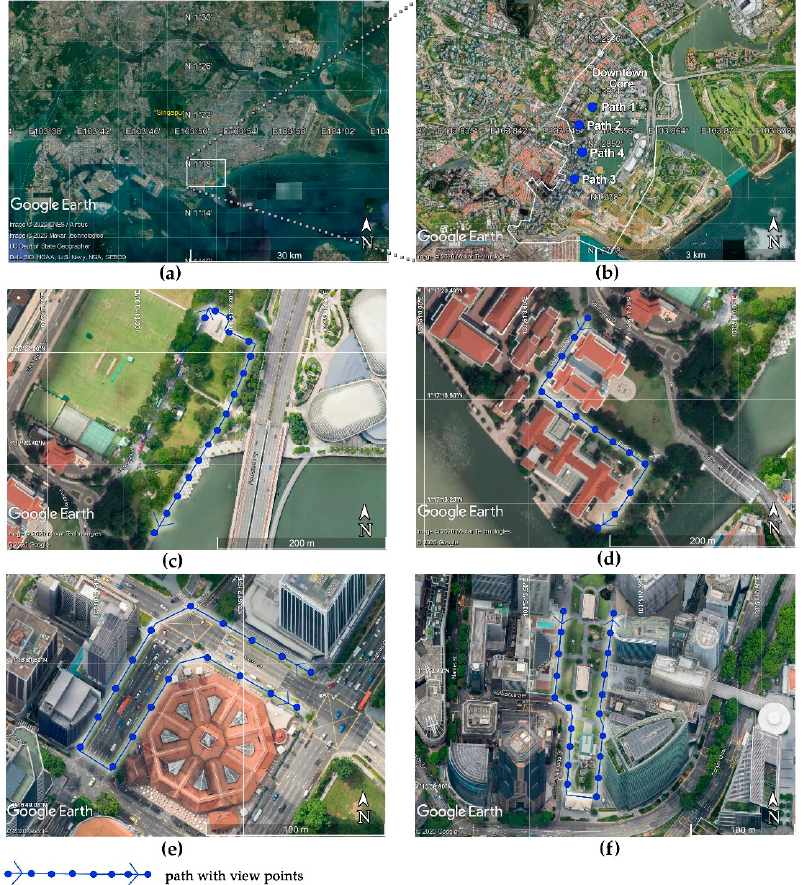
Figure 2. Study sites selection: ( a ) Singapore downtown core ( b ) 4 sample paths: ( c ) Path 1-Esplanade Park, ( d ) Path 2-Museum Area, ( e ) Path 3-Robinson Rd and ( f ) Path 4-Raffles Place Park.